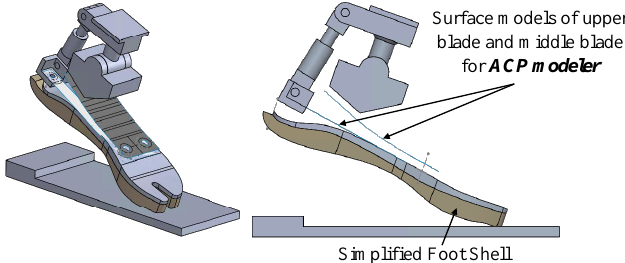
Figure 11. Isotropic parts were provided as solid, while composite components were surfaces. The Össur lower blade was assumed as isotropic with approximated properties. The foot shell was simplified considering the areas underneath the lower blade